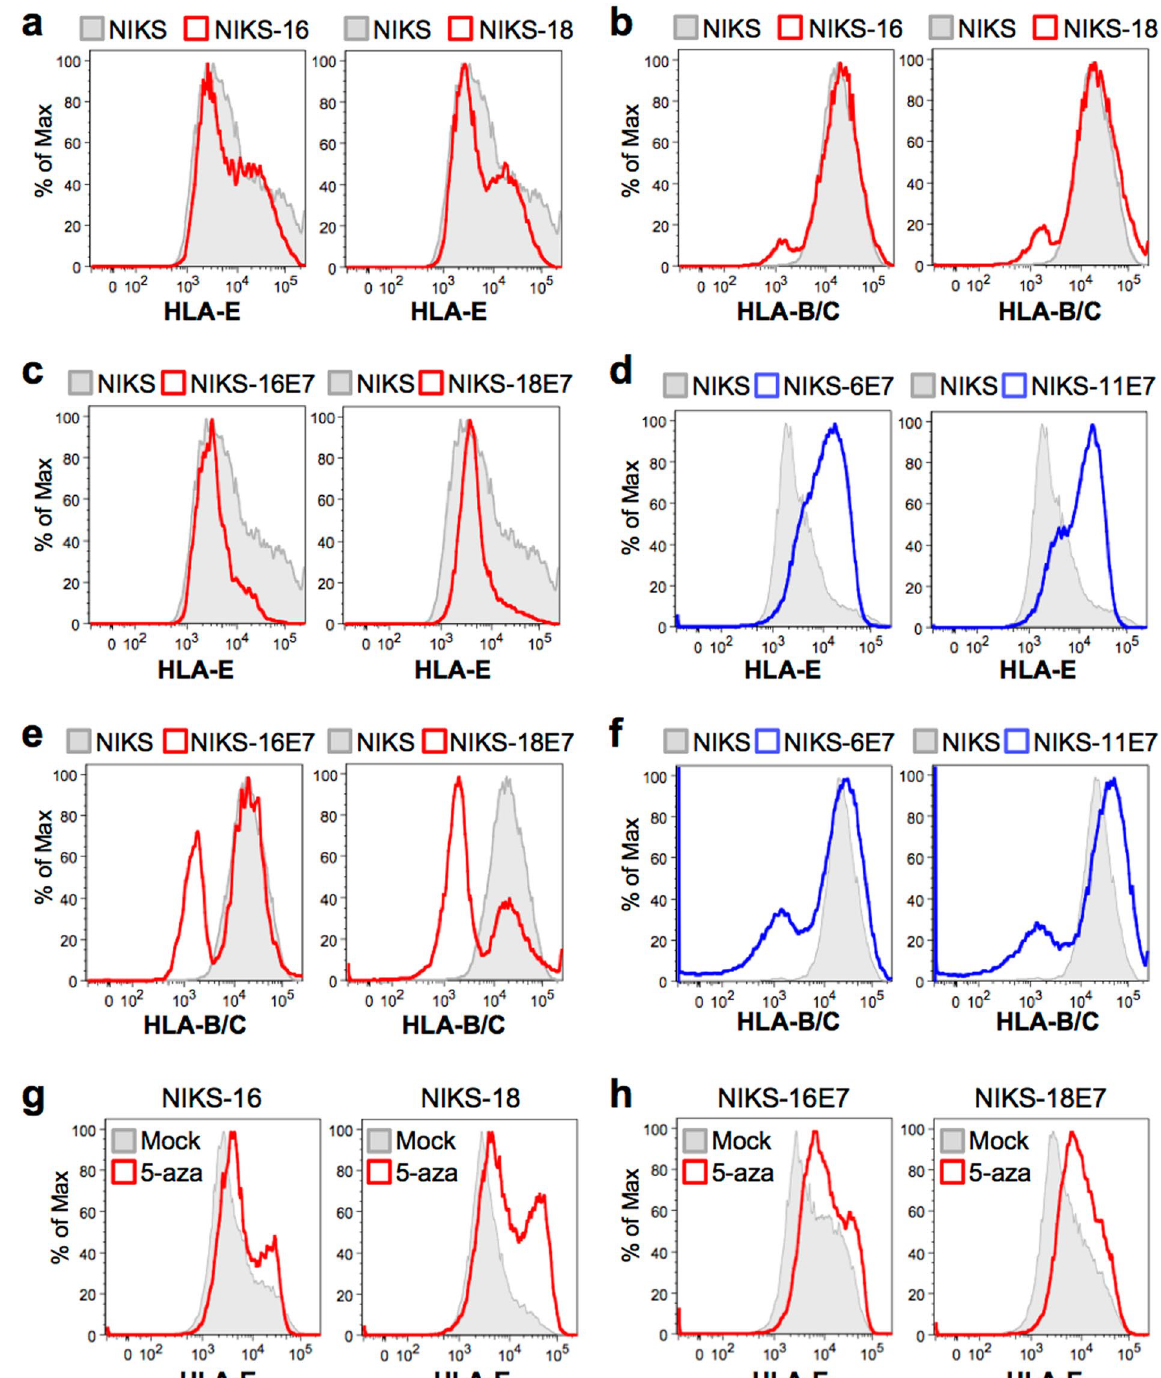
Figure 6. High-risk HPV E7, but not low-risk HPV E7, is sufficient for downregulation of HLA-E protein expression in keratinocytes. NIKS and NIKS derivative cells were dissociated to single cell populations using citric saline buffer, fixed in 4% paraformaldehyde, incubated with anti- HLA-E or anti- HLA-B/C antibodies, and assessed by flow cytometry as described in Supplementary Methods. HLA-E ( a ) and HLA-B/C ( b ) protein expression in NIKS (grey) and NIKS-16 (red) cells. ( c–f , and h ) NIKS cells stably expressing E7 from HPV6, 11, 16, and 18 (NIKS-6E7, NIKS-11E7, NIKS-16E7, and NIKS-18E7, respectively) were generated by lentiviral transduction followed by puromycin selection. HLA-E ( c and d ) and HLA-B/C ( e and f ) expression in NIKS cells (grey) and NIKS cells expressing high-risk (HPV16 and 18, red) or low-risk (HPV6 and 11, blue) E7 was analyzed by flow cytometry. HLA-E expression in NIKS-16 cells mock treated (grey) or treated with 5 μ M 5-aza (red) for five days was assessed by flow cytometry ( g and h ). Shown are representative data of three